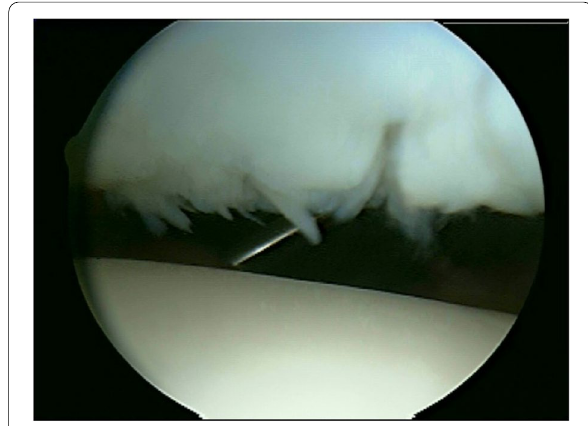
Fig. 1 Patellar cartilage lesion in the entire lateral facet, grade 4 ICRS. 113 85 mm. 2 (150 150 DPI) × ×